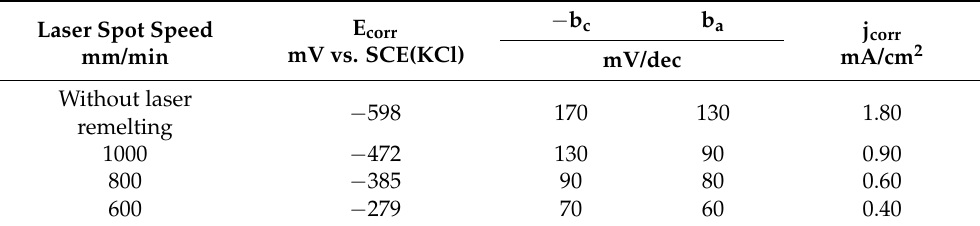
Table 3. Corrosion electrochemical parameters of the Cr 3 C 2 -25(Ni20Cr) cermet coatings on the Al7075 substrate without and with laser remelting.